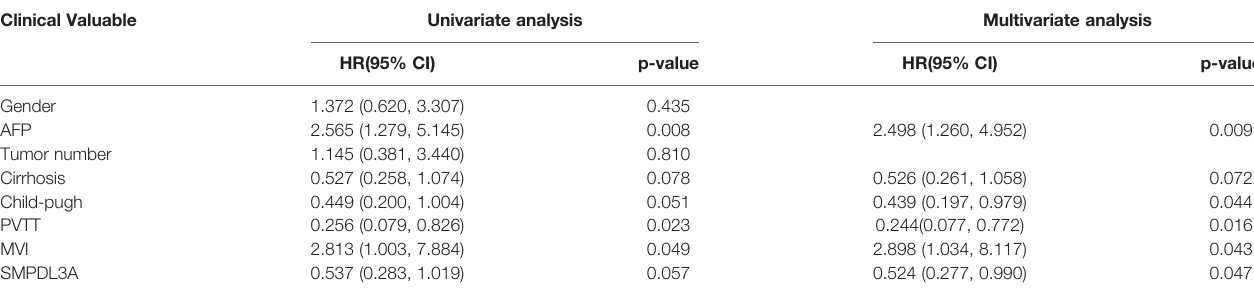
TABLE 4 | Univariate and multivariate analyses of independent risk factors for overall survival of patients with hepatocellular carcinoma after hepatectomy. Clinical Valuable Univariate analysis Multivariate analysis HR(95% CI) p-value HR(95% CI)